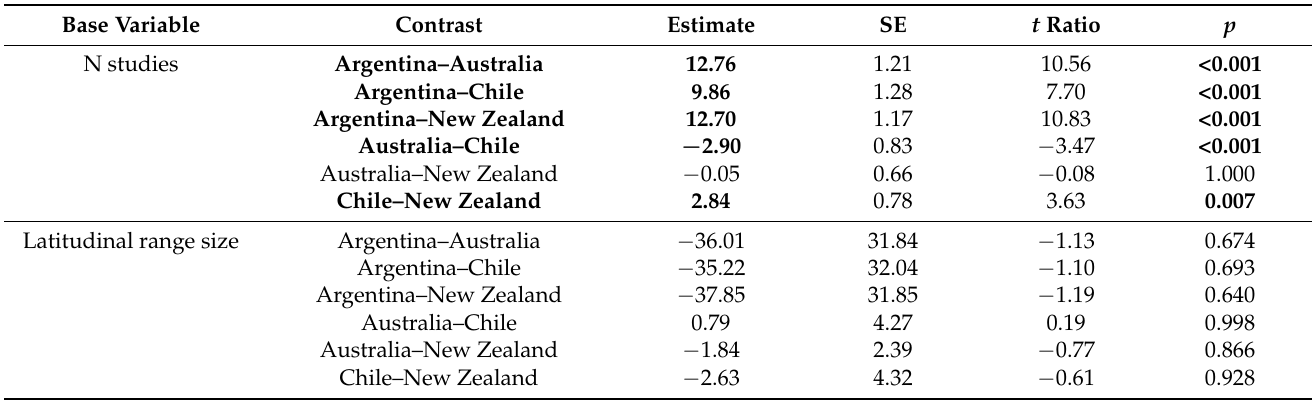
Table A2. Tukey pairwise comparisons investigating the effect of geographic region on the number of reported parasite taxa per galaxiid species in relation to number of studies. Statistically significant estimates ( α = 0.05) are in bold. Base